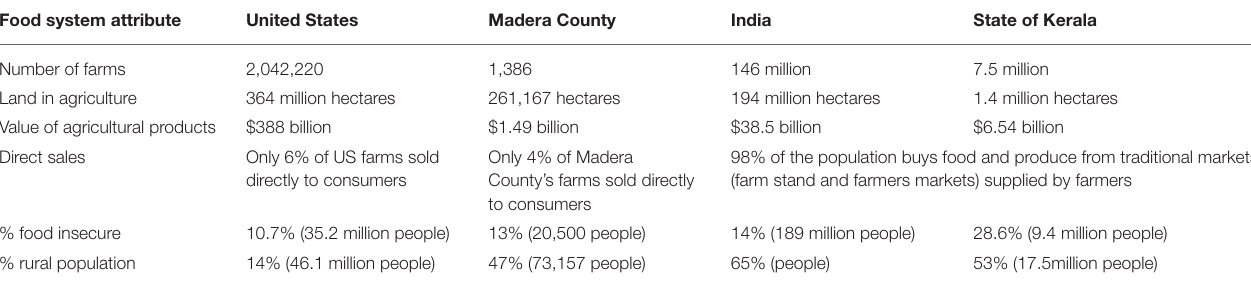
TABLE 1 | Comparative nested case study area attributes. Food system